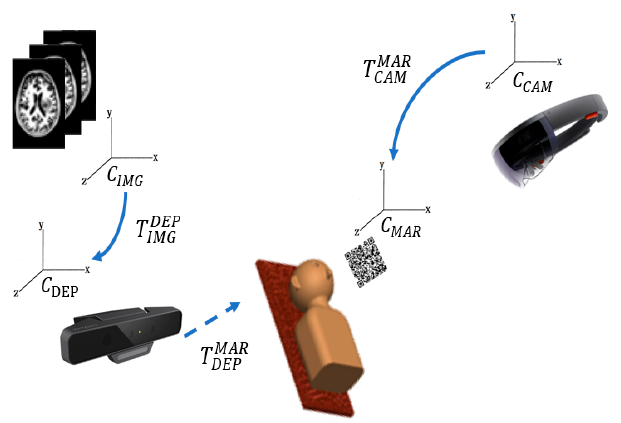
Figure 6. The process of conversion between different coordinate systems.